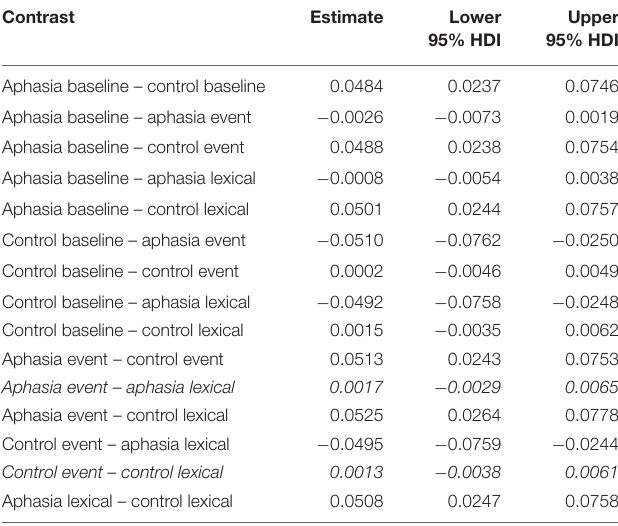
Model 3: Primed Naming Accuracy in Participants With Aphasia